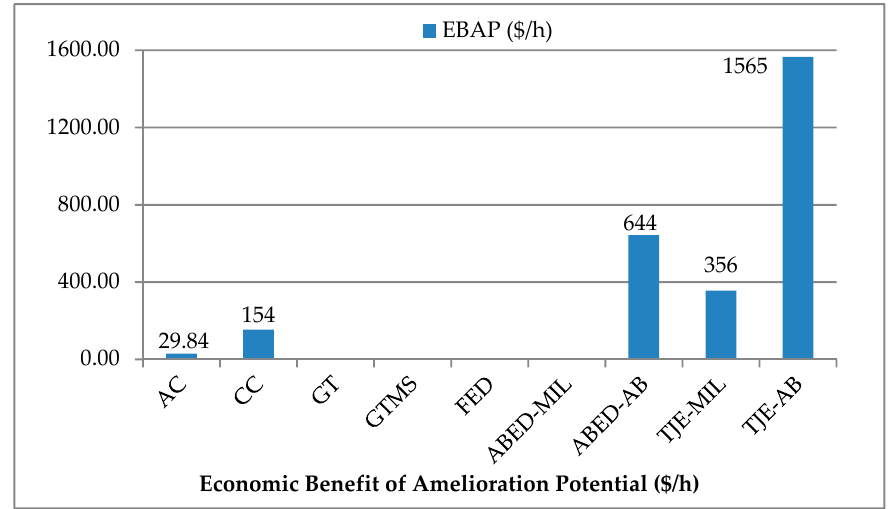
Figure 5. Economic profit of amelioration potential (EBAP) with JP-8 fuel usage.